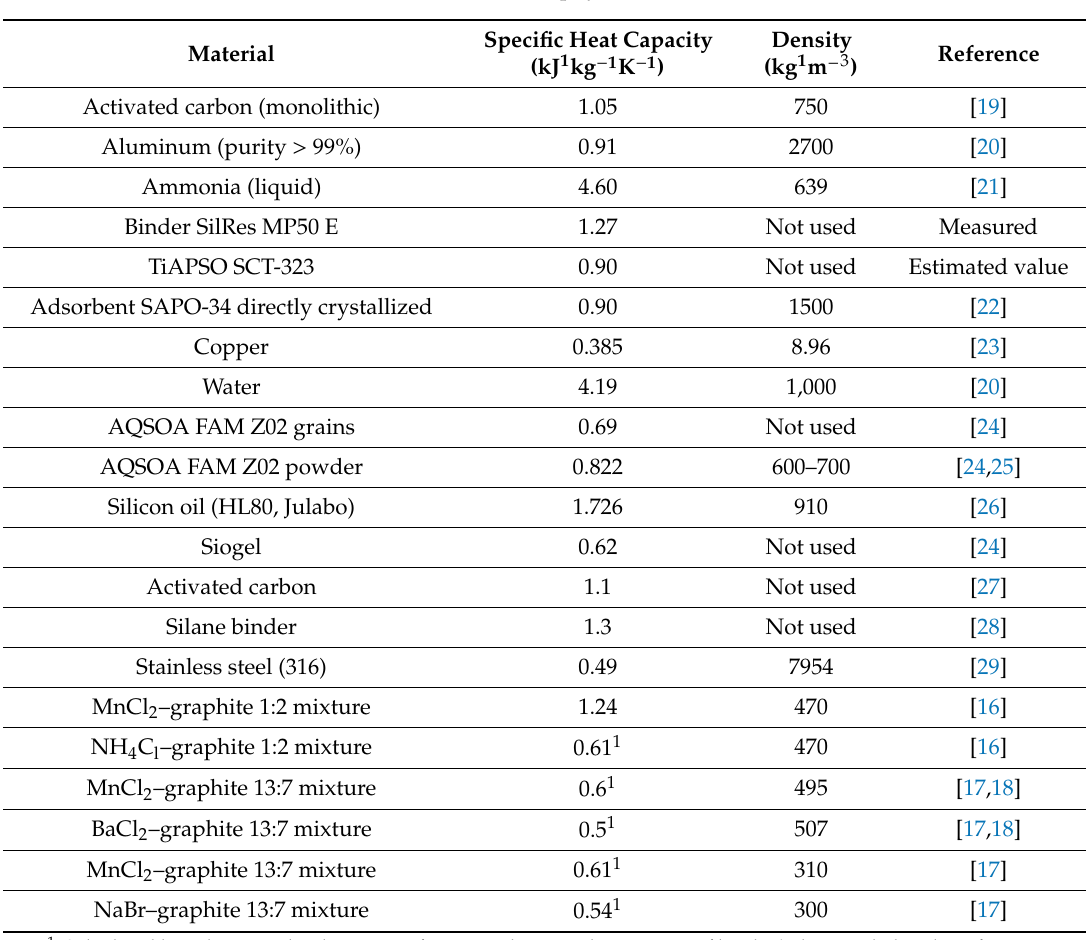
Table 3. Thermophysical